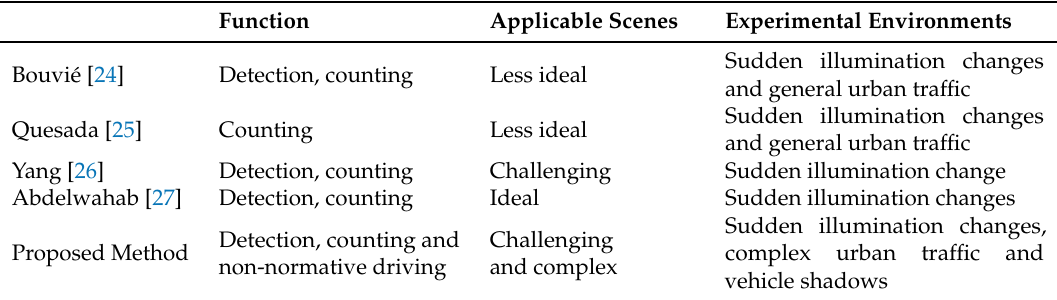
Table 1. Comparison of existing state-of-the-art